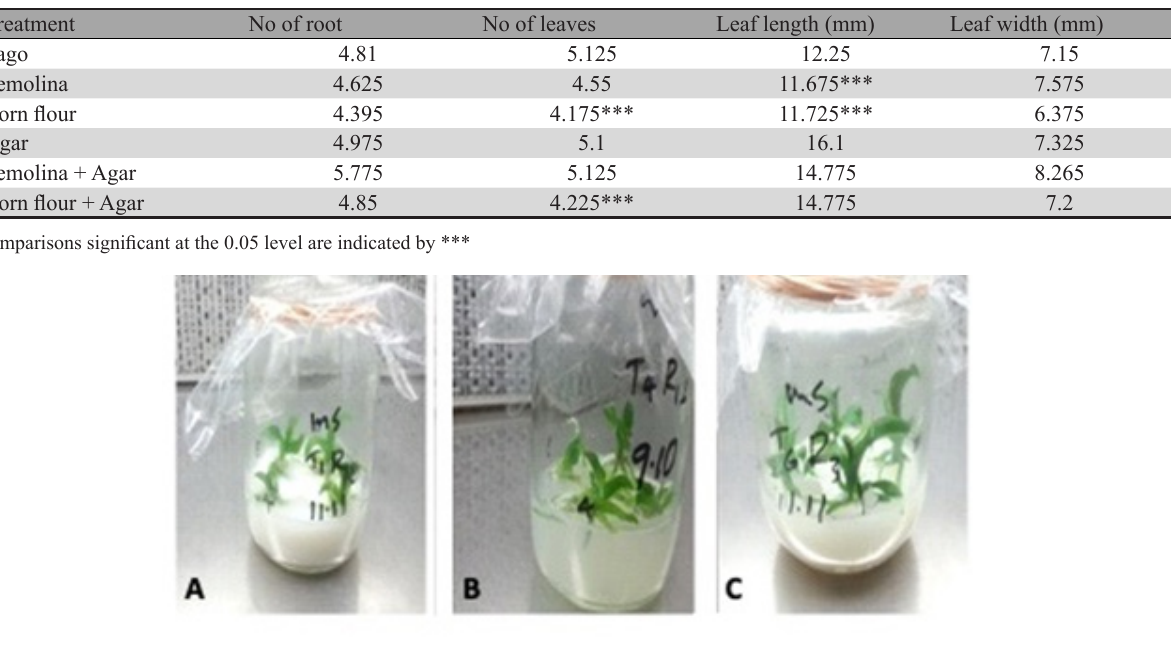
Figure 1 . Growth of Cattleya seedlings in different mediums of MS (A-Sago-Agar, C-Semolina +Agar mediums)